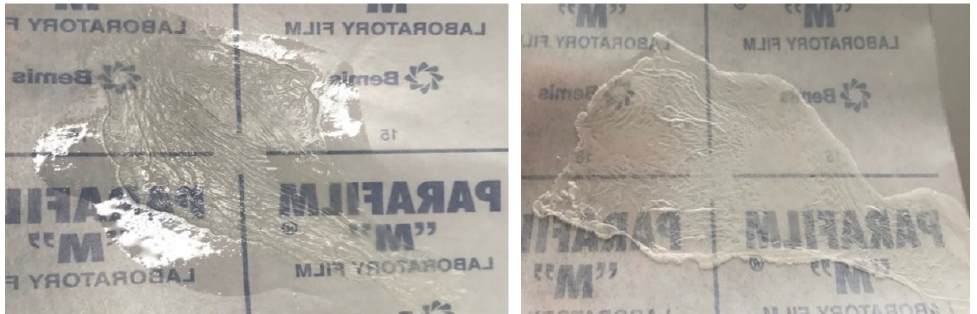
Figure 2. Film No. 7 with jojoba oil. On the left side — appearance of the film after film-forming gel preparation and application on the surface, on the right side — appearance of the film after 1 h.